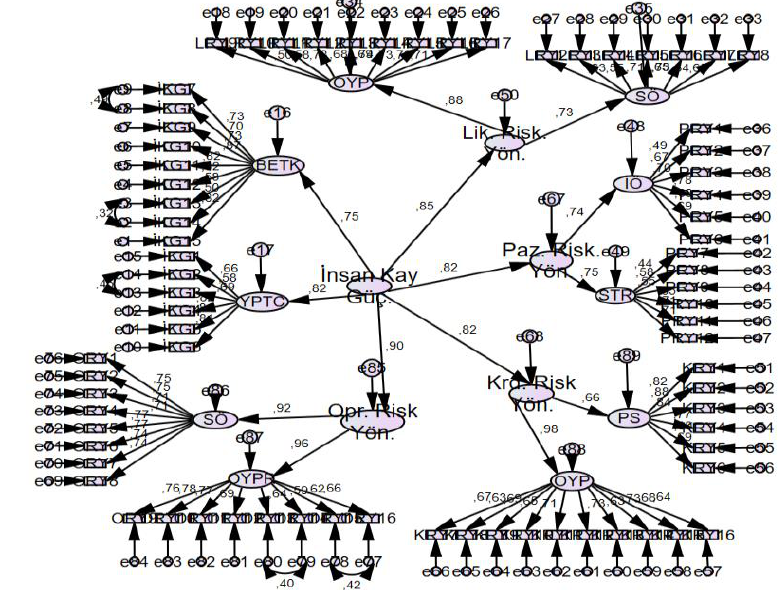
Figure 2: Structural equation model